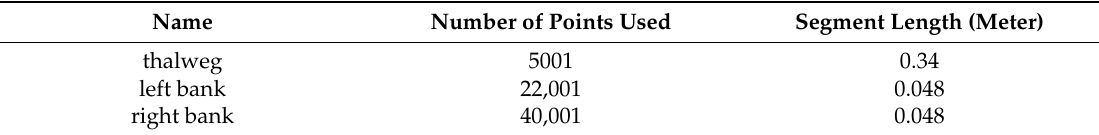
Table 1. Thalweg and river banks spline resampling